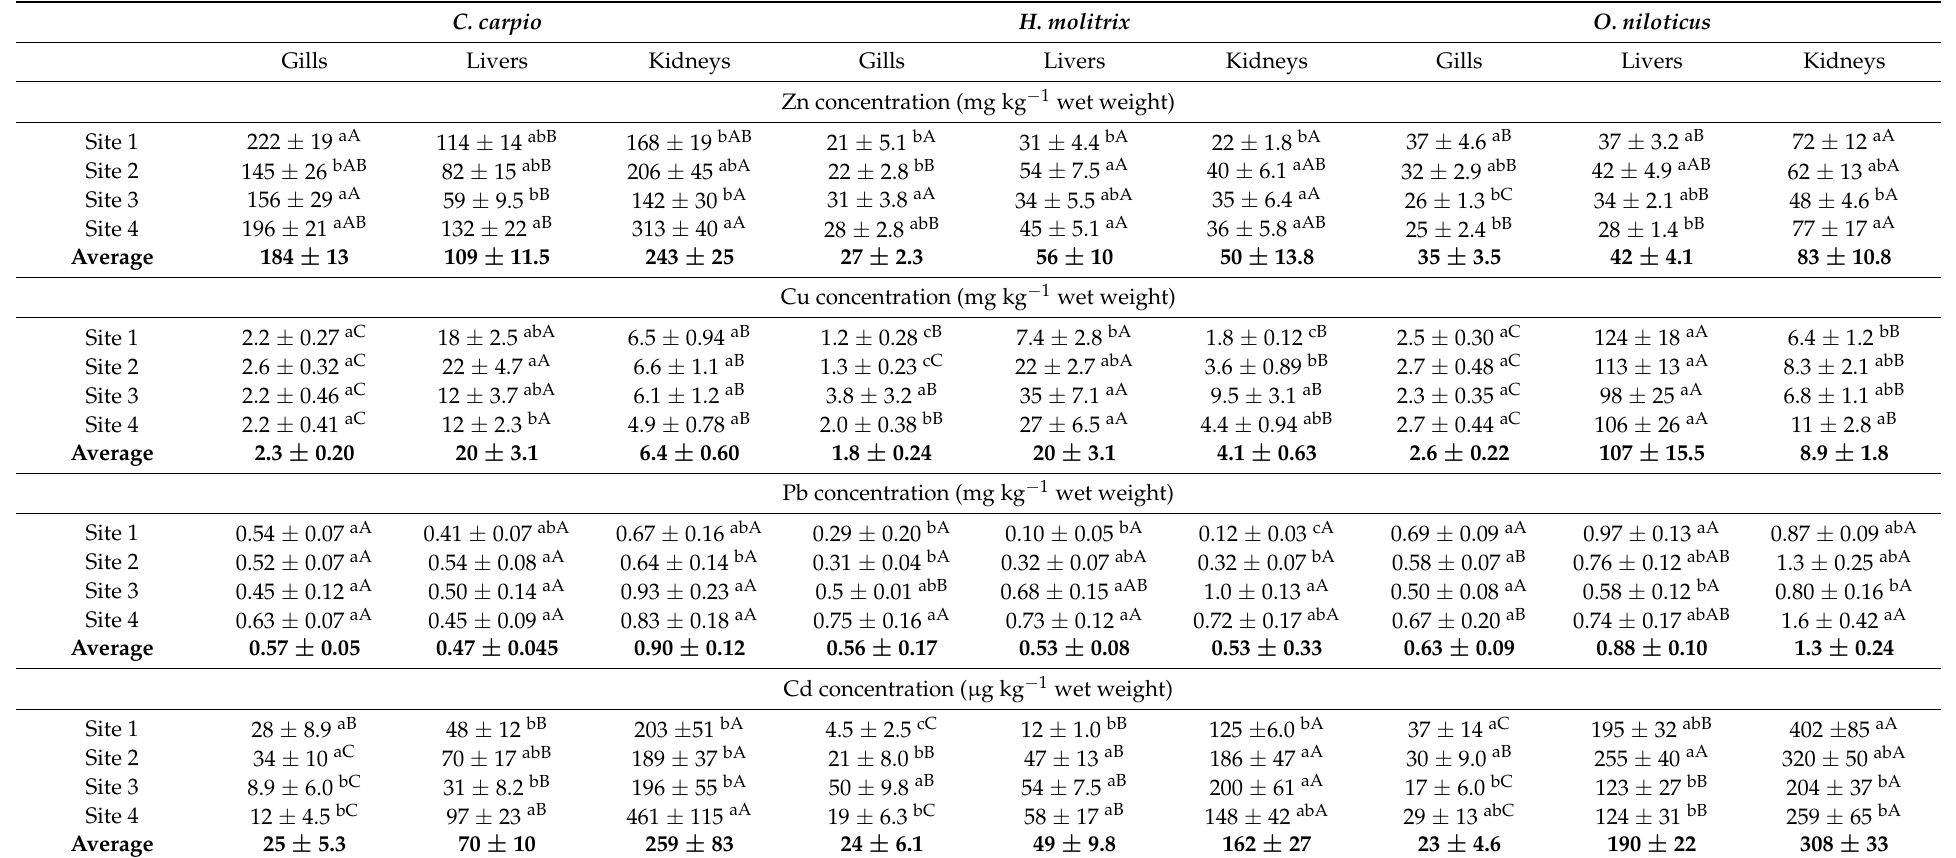
Table 2. Metal concentrations in the gills, livers, and kidneys of C. carpio , H. molitrix , and O. niloticus collected from different sites. The data are presented as mean ± SEM. Small letters (a > b > c) represent statistically significant differences between sampling sites within the same tissue samples from the same species. The capital letters (A > B > C) represent statistically significant differences between tissues of each species within each